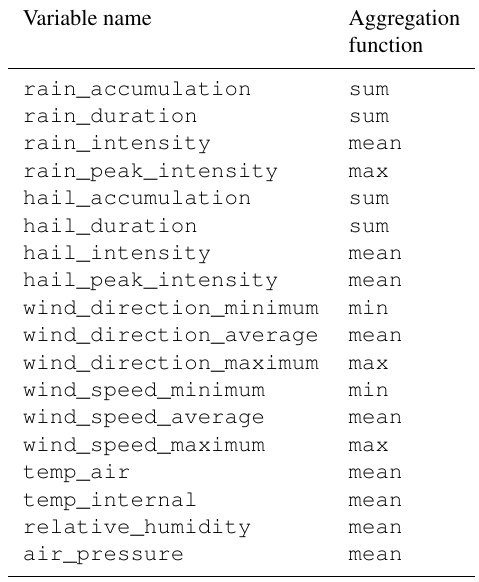
Table A1. Aggregation functions used for the meteorological data at position